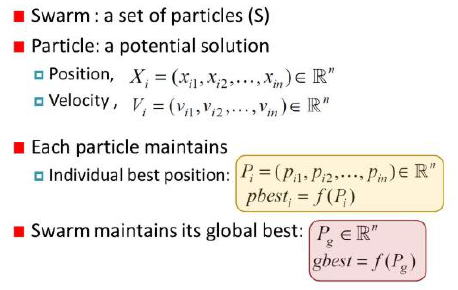
Figure 2. Particle Swarm Optimization Main